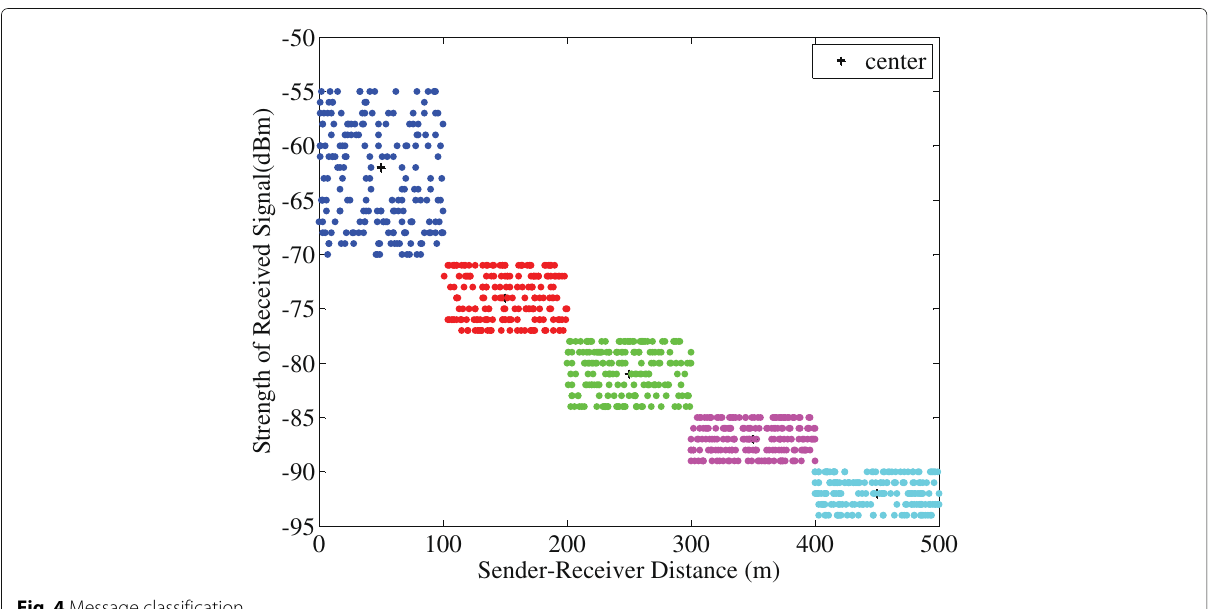
Fig. 4 Message classification